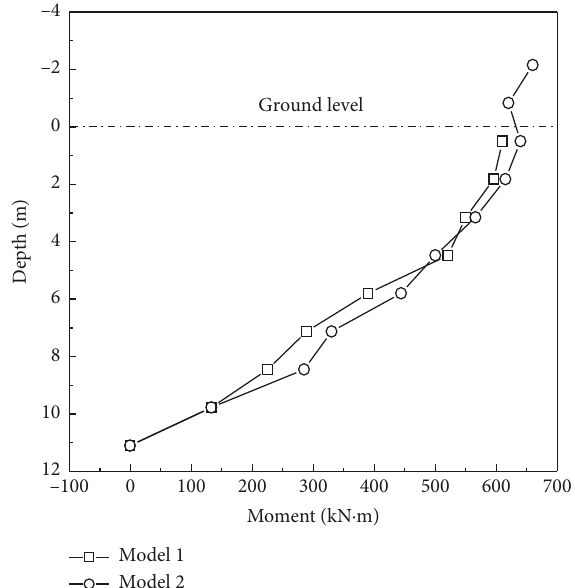
Figure 20: Contrastive analysis of bending moment of vertical piles.